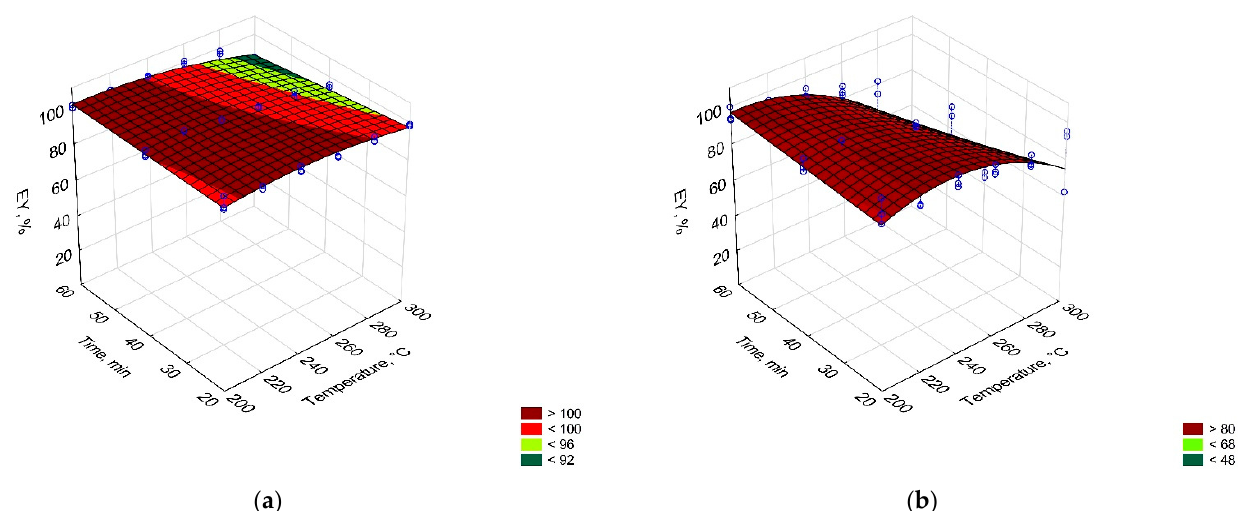
Figure 4. Temperature and time effect on the energy yield (EY) of carbonized solid fuel made from ( a ) PLA and ( b ) PAP.